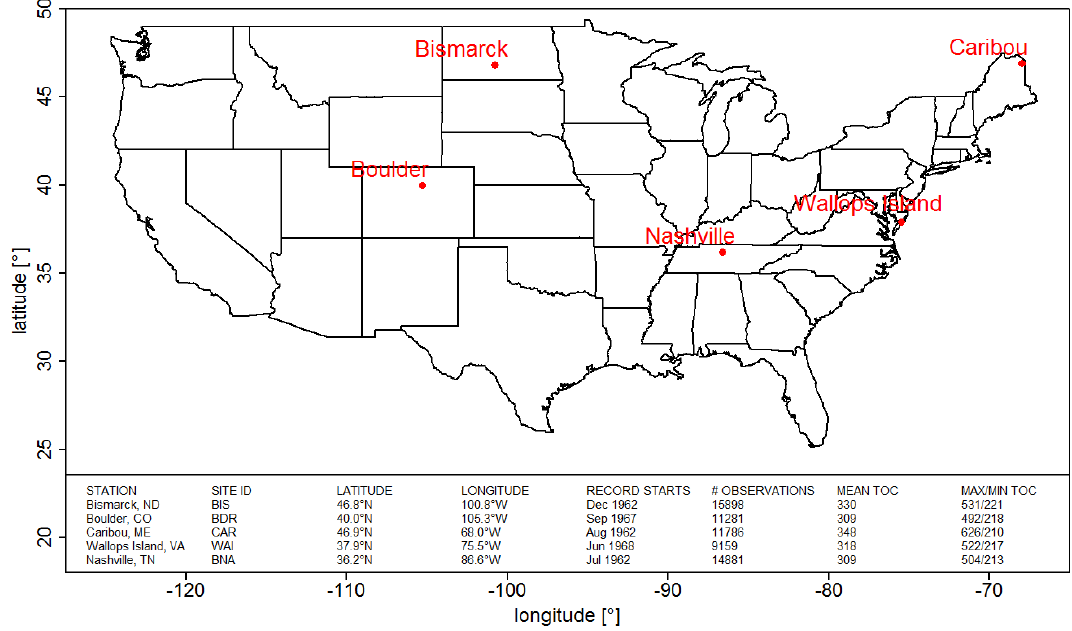
Figure 1. Geographical overview and site-specific information for the USA long-term Dobson total ozone monitoring sites.